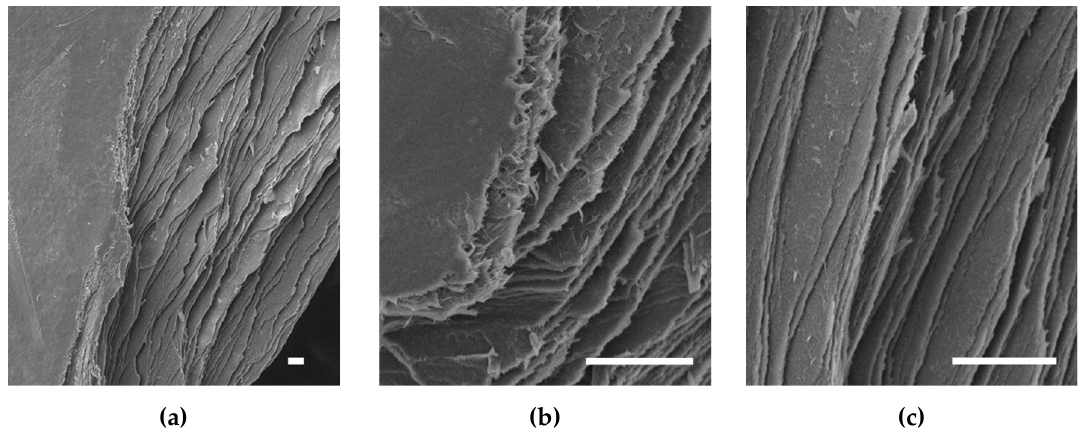
Figure 4. SEM images of 4.5 mm AJP RHCIII samples at the edges where they were torn apart, illustrating the distinct layers from the printing process. ( a ) Full section view showing smooth sample surface and layers beneath. Higher magnification images showing, ( b ), fibrous structures at observed at tear-edges, and ( c ), density of the layers at the sections. All scale bars represent 10 µm.